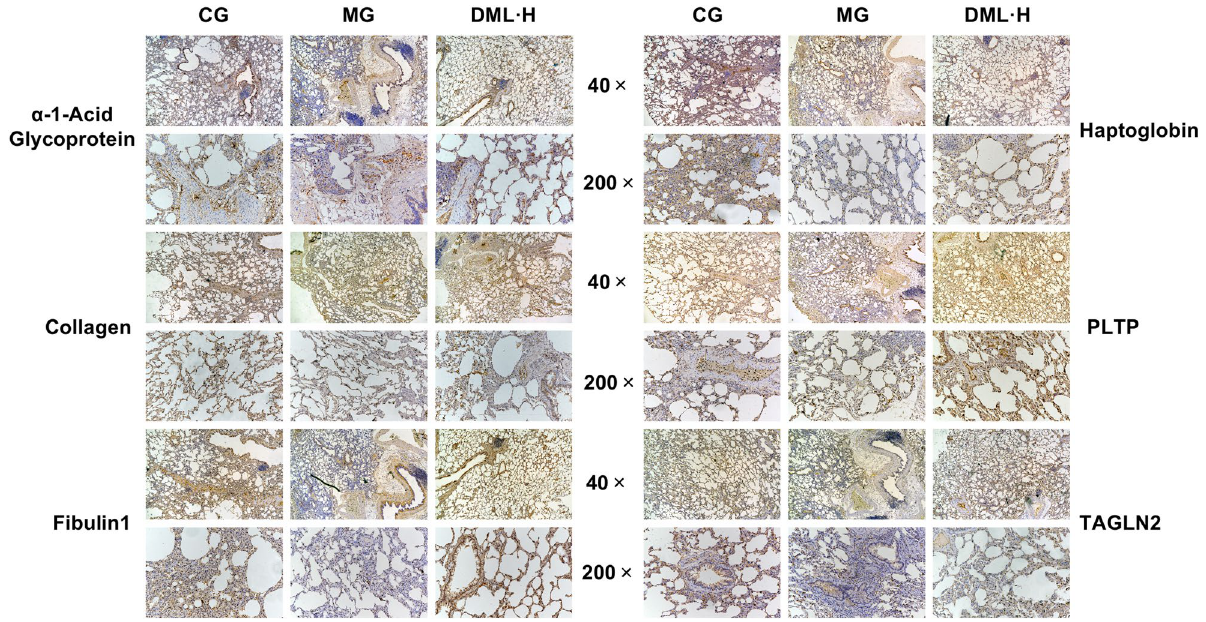
Figure 7. Immunohistochemical staining of DEPs. Positive immunostaining of α-1-acid glycoprotein, collagen, fibulin, haptoglobin, PLTP and TAGLN2 in CMS. These proteins were clearly suppressed in the DML·H